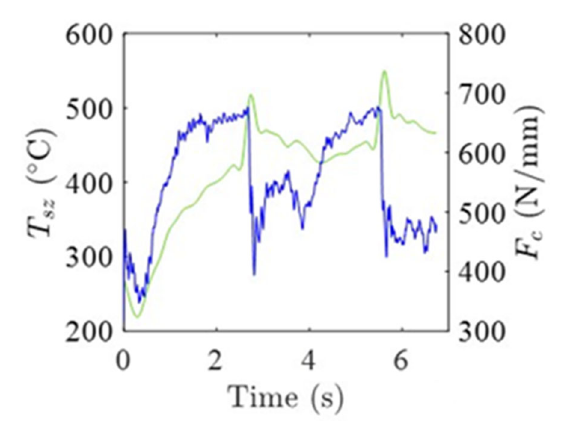
Figure 15. Temperature (green) and force (blue) evolution during orthogonal cutting of Ti6Al4V (FEM model). Cutting conditions: V c = 7.5 m/min and f = 0.4 mm. Time scale ×10 − 3